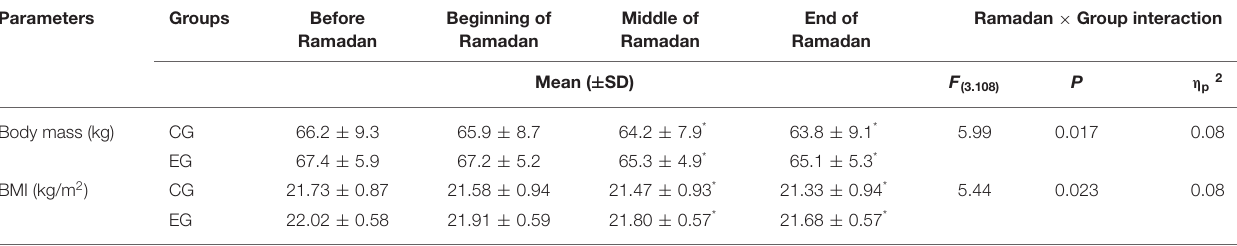
TABLE 3 | Averages ( ± SD) of body mass and BMI recorded before and during Ramadan. Parameters